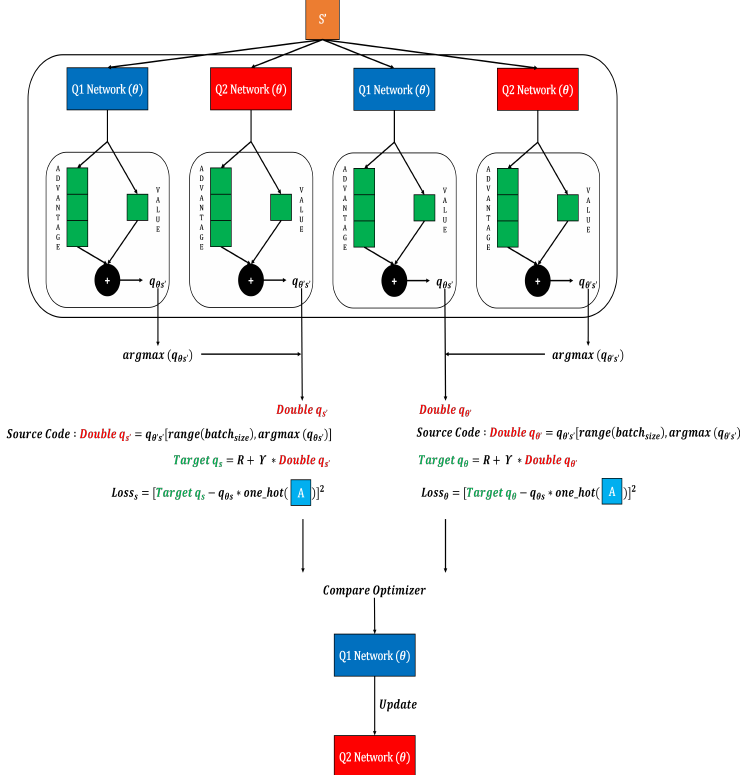
Figure 4. Quad Q Network plot created by duplicating Q1 and Q2, followed by two argmax processes and comparison of Loss values.